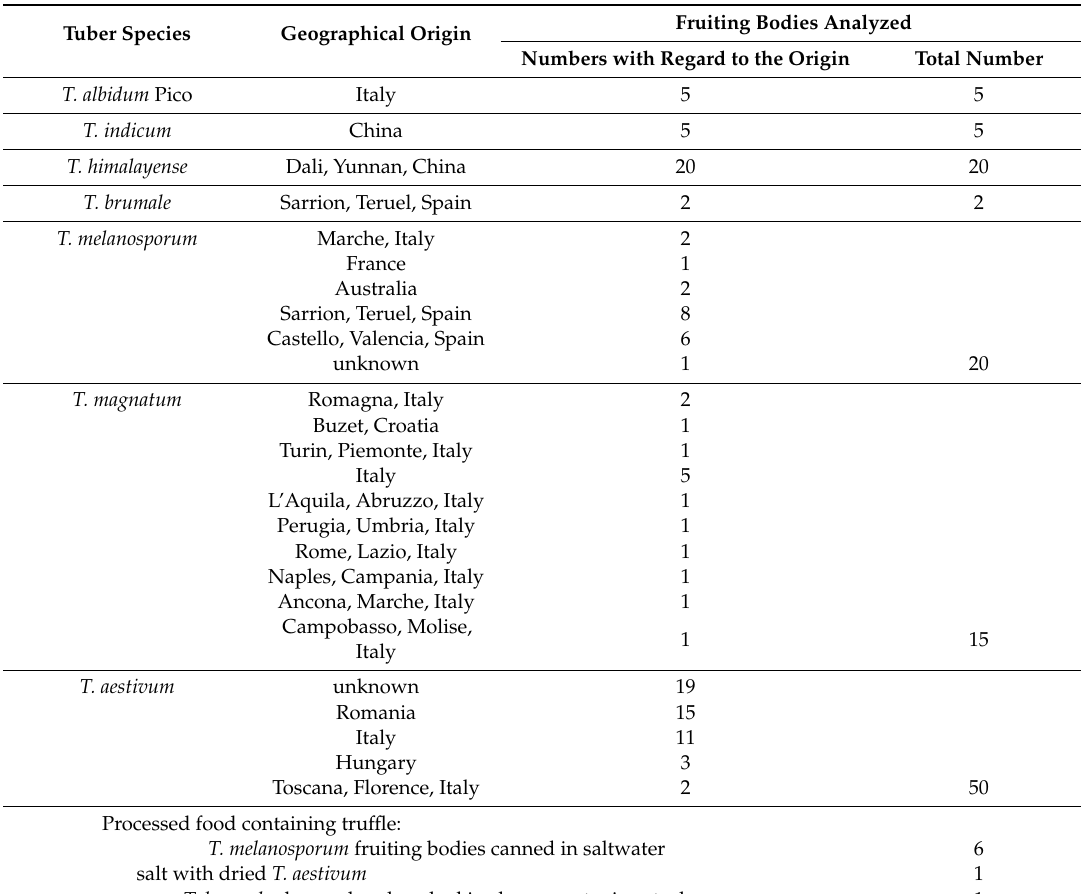
Table 1. Sample material used in this